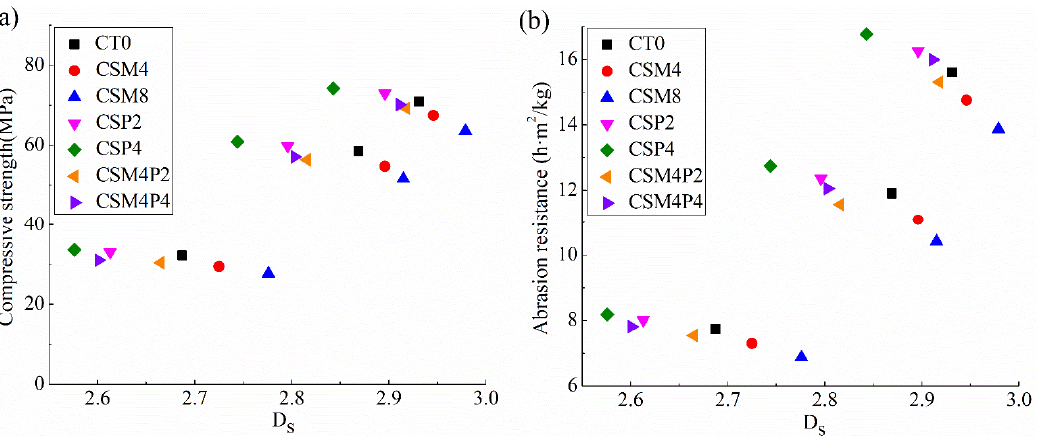
Figure 11. The relationships between the D s and ( a ) compressive strength and ( b ) abrasion resistance of hydraulic concretes containing MgO and/or PVA fiber.